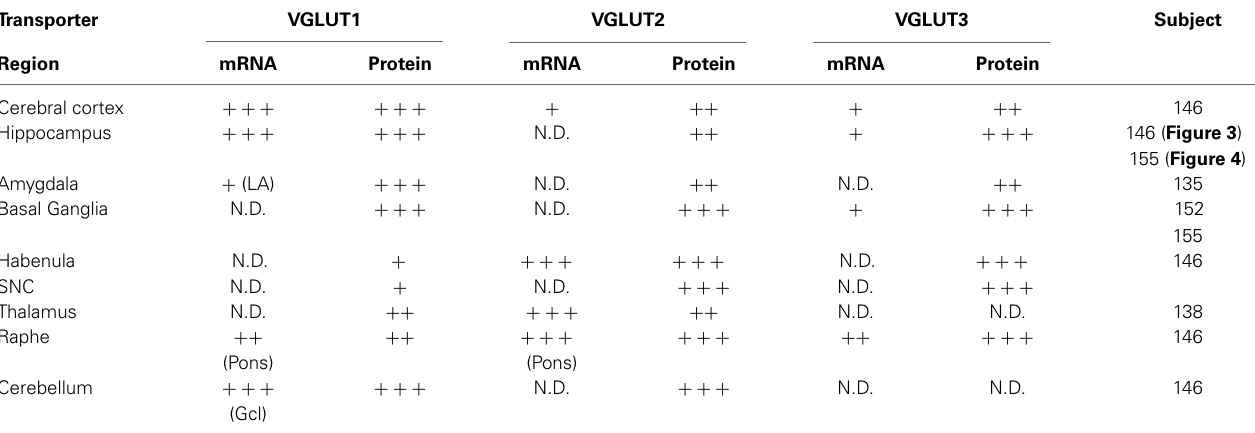
Table 3 | Distribution of VGLUT1-3 transcripts and proteins in various area of the human brain. Transporter